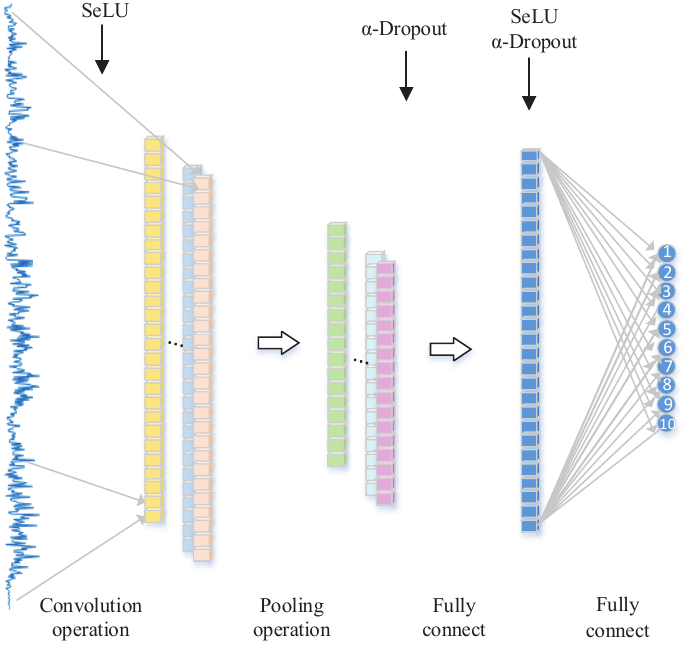
Figure 2. The architecture of the proposed 1D-SCNN method for fault